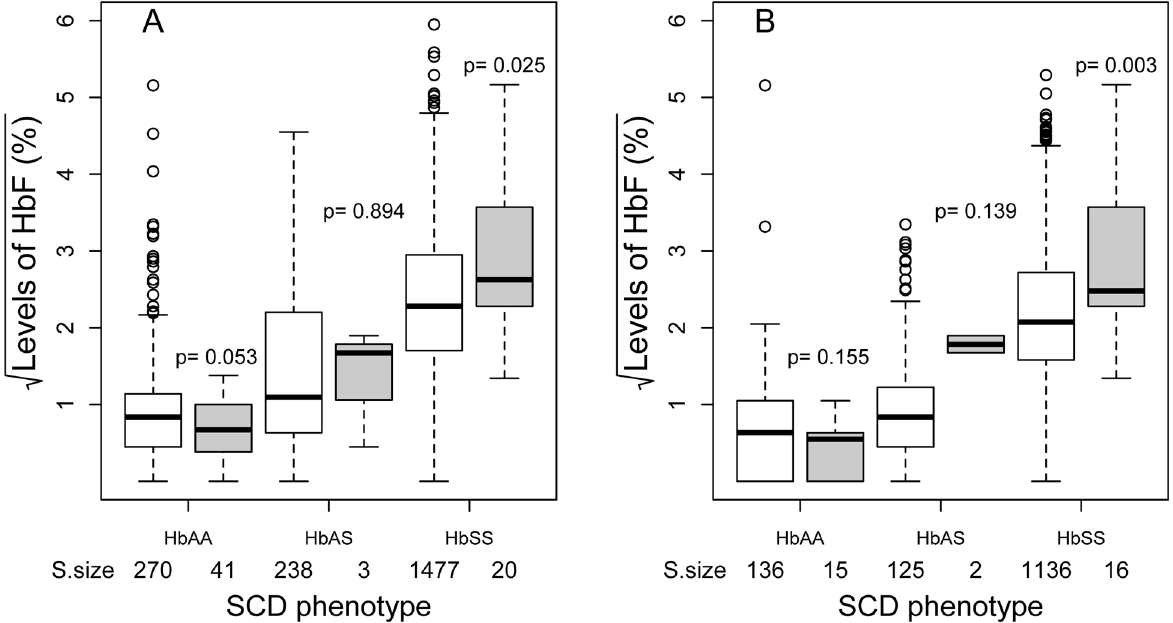
Fig 2. Association between malaria (Blank = Negative, Filled = Positive) by SCD and Foetal hemoglobin levels for individuals in all ages (A) and for (cid:1) 5 years (B). Sample size of each group is shown on the x-axis and p-values (p) in the graph were derived from t-tests (HbAA and HbSS) and Wilcox sign rank test (HbAS). The box show median (central line) and inter quartile range (IQR). The top whisker corresponds to the largest observation that is less than or equal to the 75th percentile + 1.5 x IQR. The bottom whisker corresponds to the smallest observation that is greater than or equal to the 25th percentile — 1.5 x IQR, while open circles are the outliers.